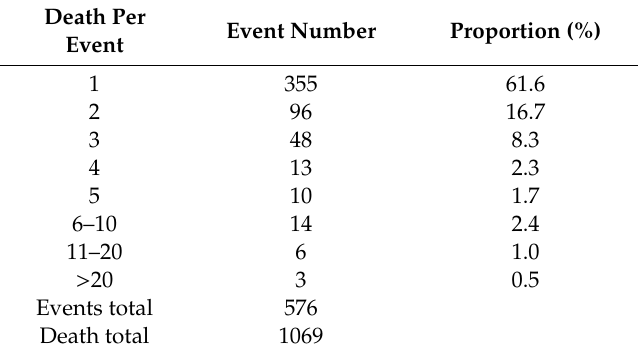
Table 1. Death per flood event in Texas, 1959–2019.